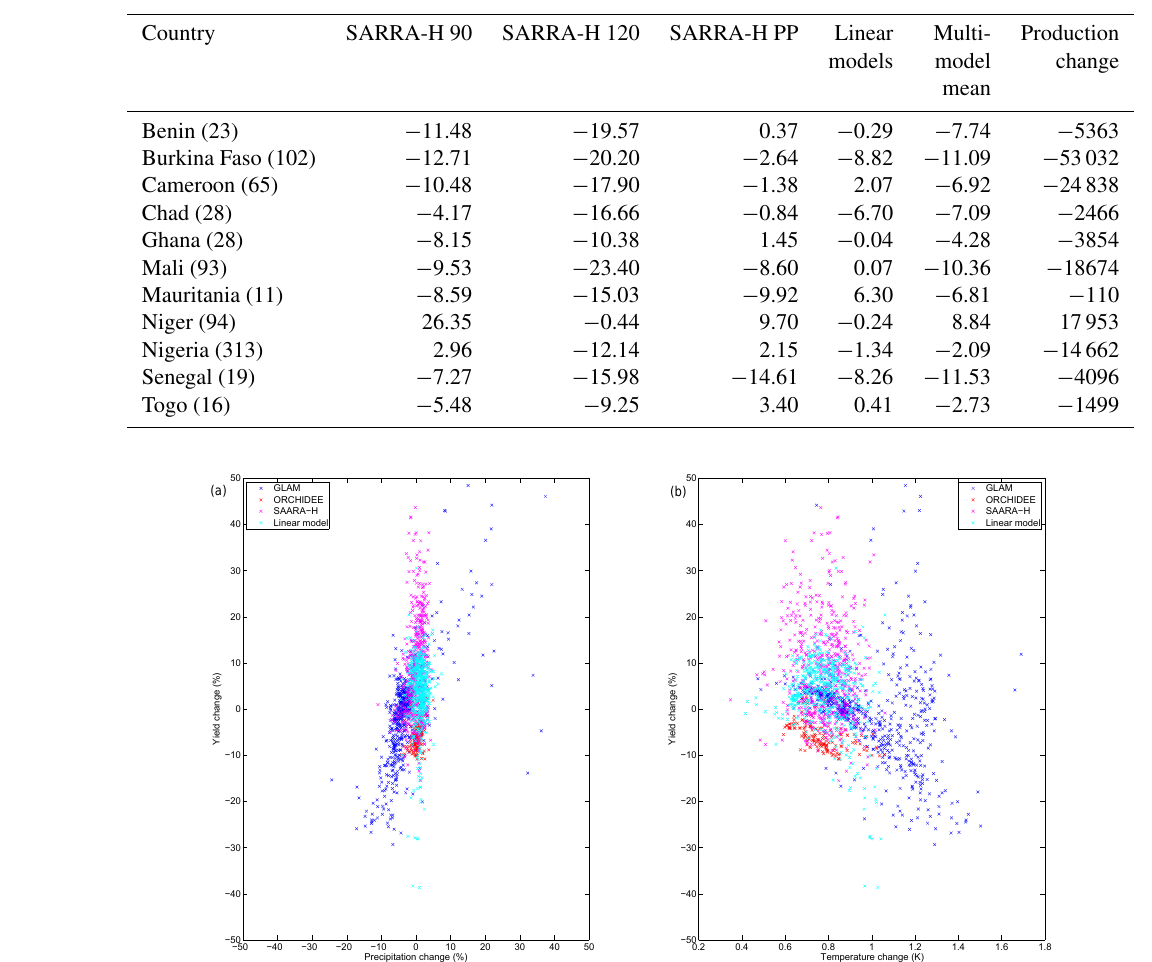
Figure 5. Percentage maize yield change against precipitation (a) and temperature (b) for four crop models. This figure has a restricted x axis in the precipitation plot to enhance the clarity of the results and a full version is shown in Fig.